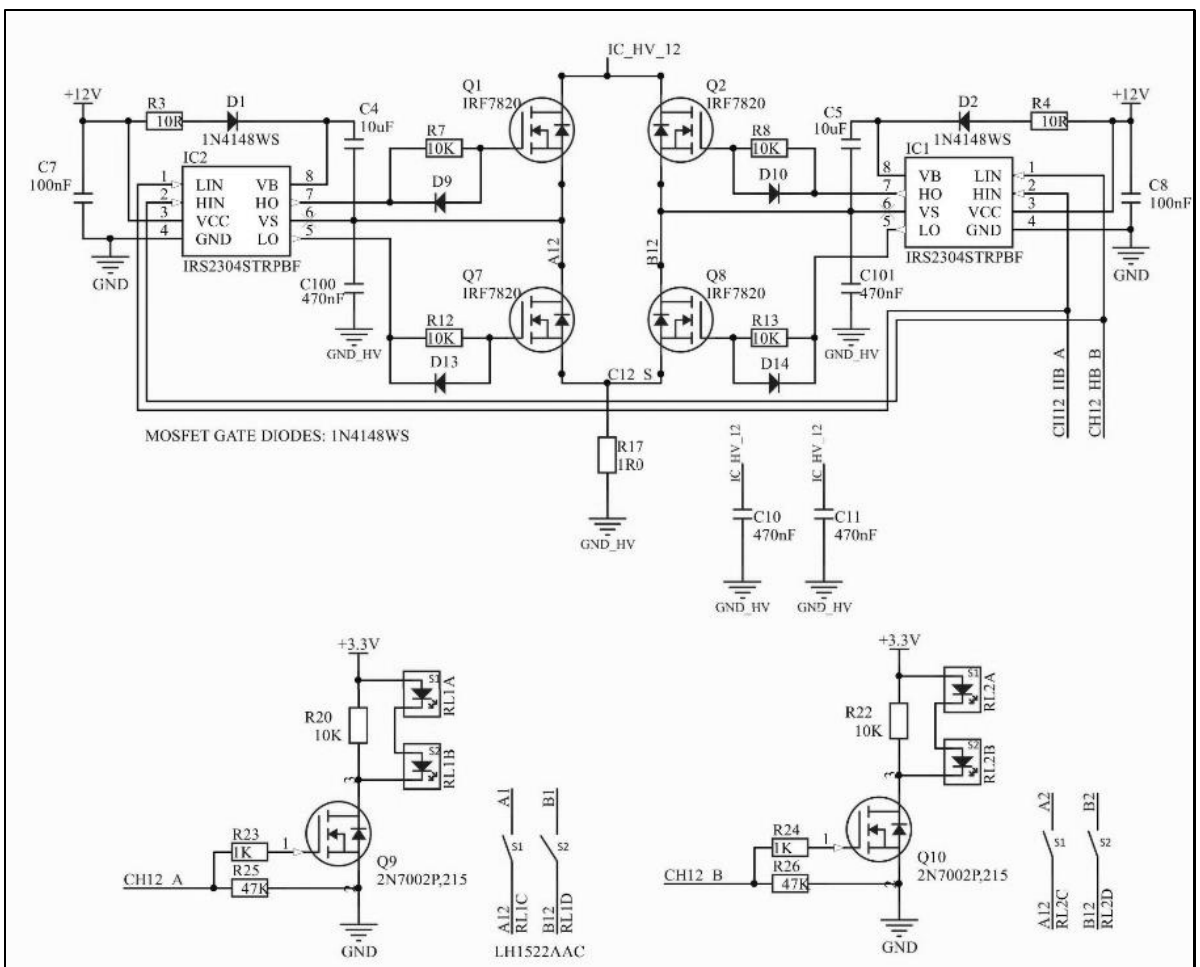
Figure 3. H-bridge circuit and circuitry for activating channels A and B of one of the four independent output channels. The net IC_HV_12 corresponds to the output current signal of the Wilson current mirror (Figure 2). Two independent solid-state relays can be activated, but not simultaneously. Capacitors C100 and C101 are optional.